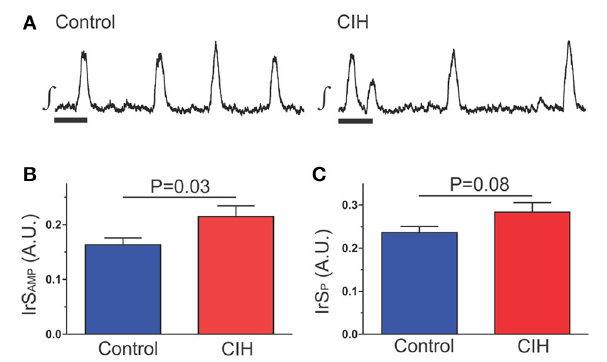
FIGURE 2 | CIH increases the burst-to-burst irregularity of the isolated preBötC rhythm. (A) Representative examples of integrated traces of preBötC activity taken from control and CIH exposed mice. Scale Bar: 2s (B) Comparison of the IrS AMP of rhythmogenesis for control and CIH groups showing that following CIH IrS AMP is increased. (C) Although the P -value for the comparison of IrS P between control and CIH groups was > 0.05, the F -ratio and its corresponding P -value indicated that CIH produced a large degree of variability in IrS P and suggests that CIH indeed affects the burst-to-burst irregularity in period as previously reported ( Garcia et al.,